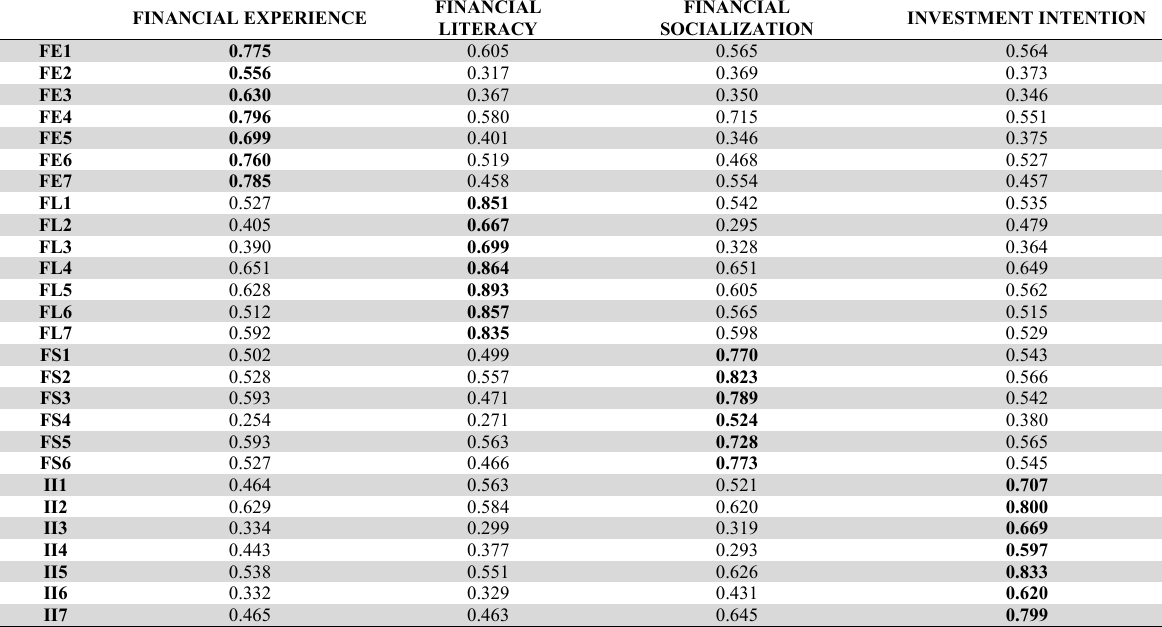
Discriminant validity — HTMT